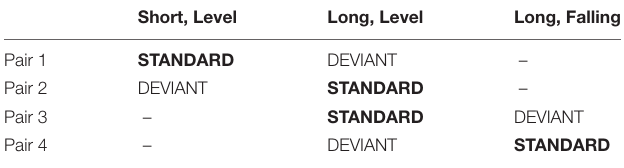
TABLE 2 | Description of the stimulus pairs used for